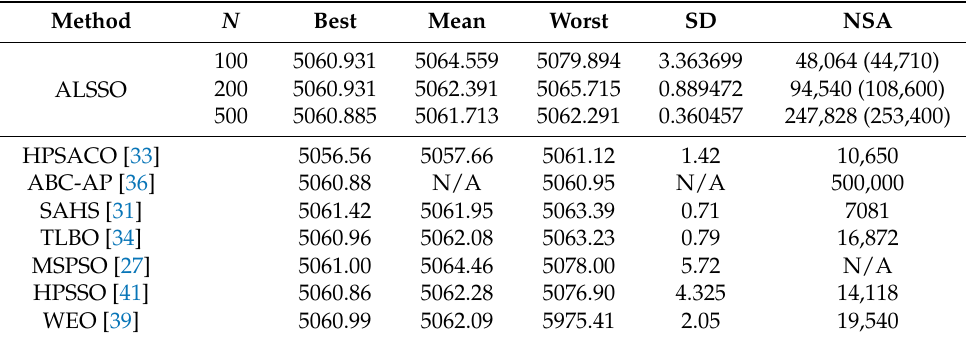
Table 2. Comparison of statistical performance in the 10-bar truss problem.